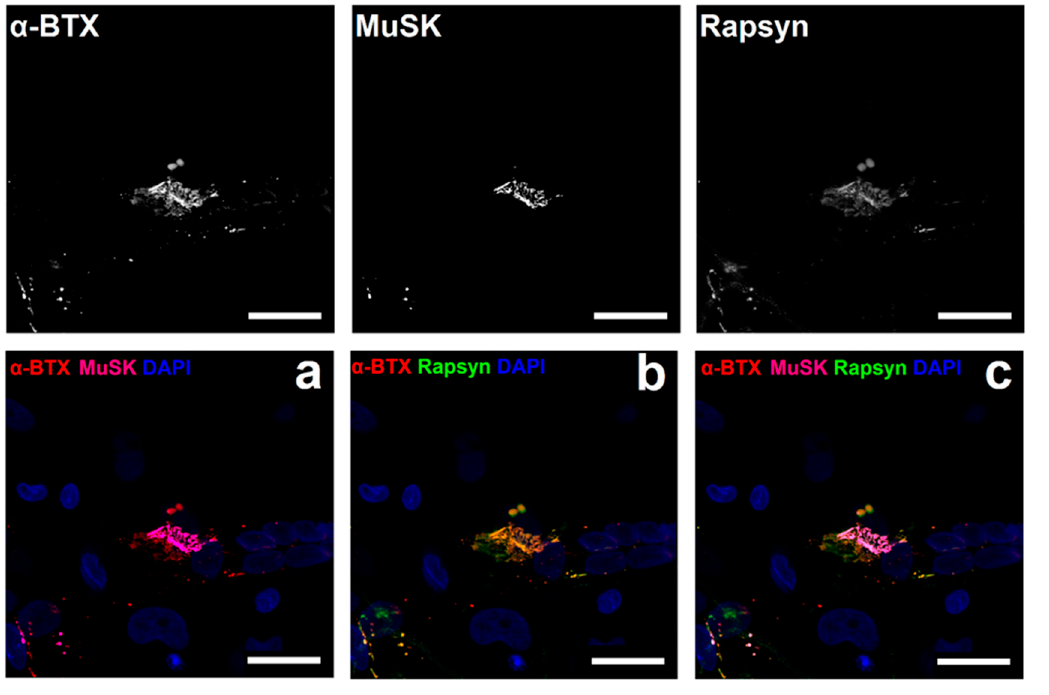
Figure 6. Characterisation of postsynaptic neuromuscular junction formation at Day 14. ( a ) shows co-culture stained for alpha-bungarotoxin ( α -BTX) (red), MuSK (magenta) and DAPI (blue). ( b ) is representative of co-culture stained for α -BTX (red), Rapsyn (green) and DAPI (blue). ( c ) reveals interaction and detailed conformation of postsynaptic proteins MuSK (magenta) and Rapsyn (green) at the AChR stained with α -BTX (red) and DAPI (blue). Scale bar = 25 µm.